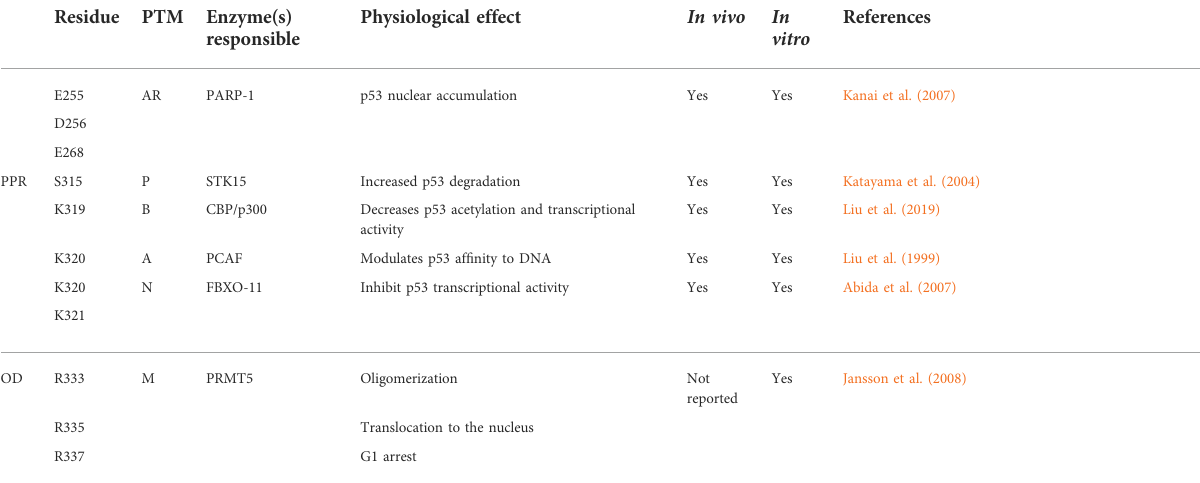
a Constitutively phosphorylated in unstressed cells. P, Phosphorylation; C, Crotonylation; U, Ubiquitination; UF, UFMylation; H, Hydroxilation; A, Acetylation; AR, ADP-Rybosilation; M, Methylation; N, NEDDylation; B, β - hydroxybutyrylation; S, SUMOylation; ATM, ataxia telangiectasia mutated; ATR, ataxia telangiectasia and Rad3 related; CBP, CREB binding protein; CK1, casein 1 kinase; Chk2, checkpoint kinase 2; DNAPK, DNA-dependent protein kinase; DYRK2, dual-speci fi city tyrosine-phosphorylation-regulated kinase 2; ERK, extracellular signal-regulated kinase;